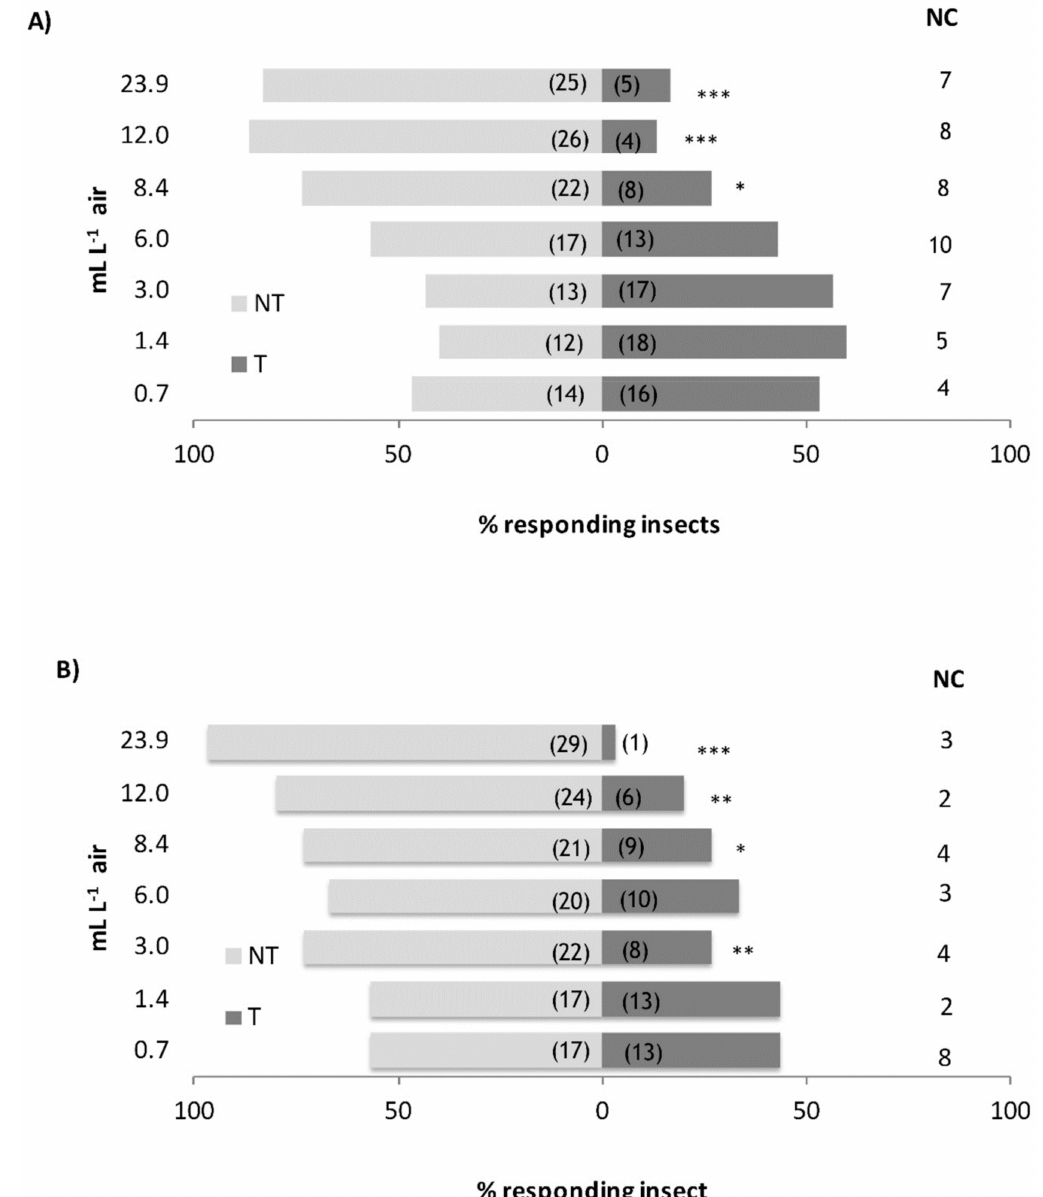
Figure 1. Behavior of adults of Sitophilus zeamais in the presence of Clinopodium nubigenum and C. tomentosum essential oils (EOs). Histograms represent the percentage of insects that chose the cue or the control chamber. In brackets, the number of insects that made the choice. NT, % of insects that chose the control chamber; T, % of insects that chose the EO treated chamber; NC, number of non-choosing insects. Each EO was tested vs. clean filter paper in two-choice bioassays. Asterisks indicate significant di ff erences in the number of the choosing insects ( χ 2 test; *, p < 0.05; **, p < 0.01; ***, p < 0.001). ( A ), C. nubigenum EO; ( B ), C. tomentosum